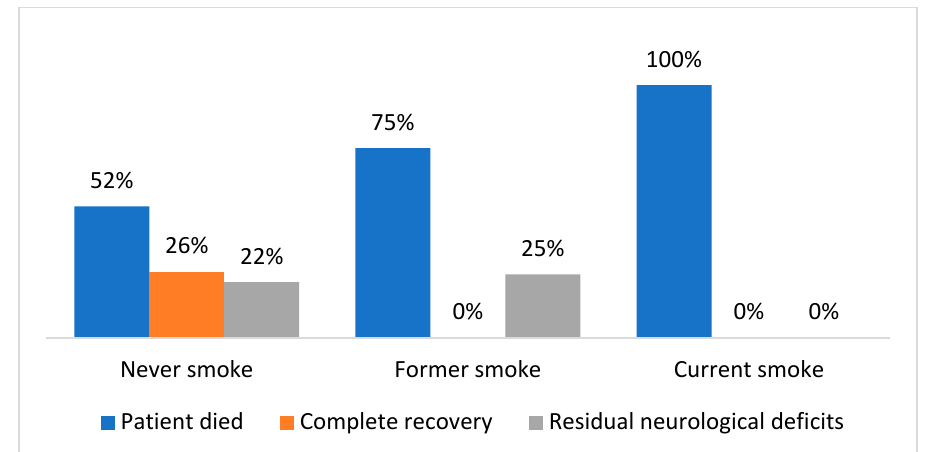
Figure 2. Percent distribution of smoking status of patients.